Question: Sum up the contents of this chart in one sentence.
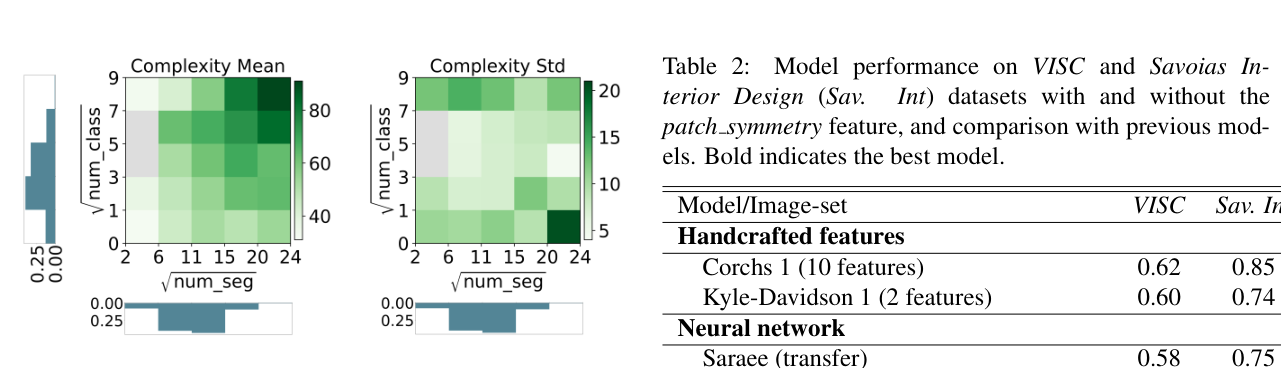
Answer: Mean and standard deviation of the ground truth subjective complexity in different bins of √num seg and √